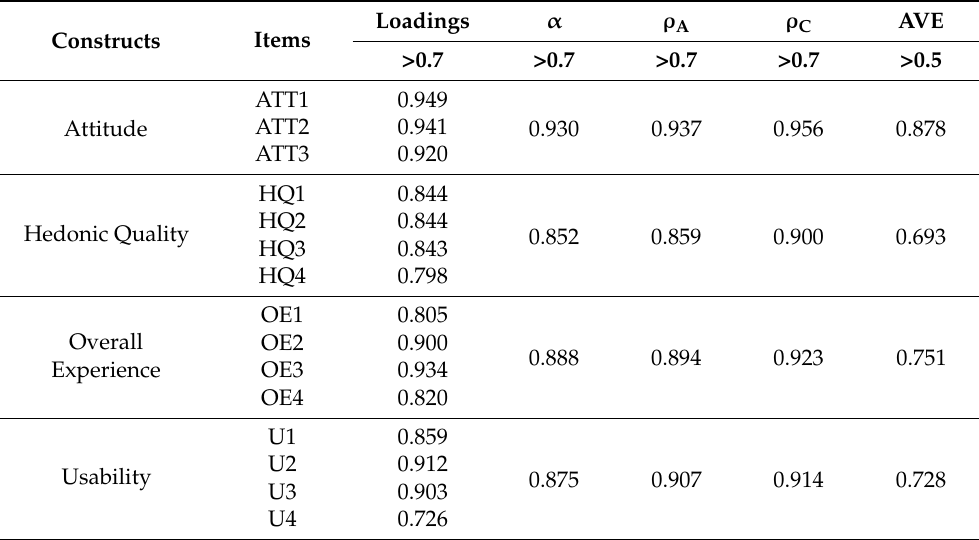
Table 2. Assessment results of reliability and validity of measurement